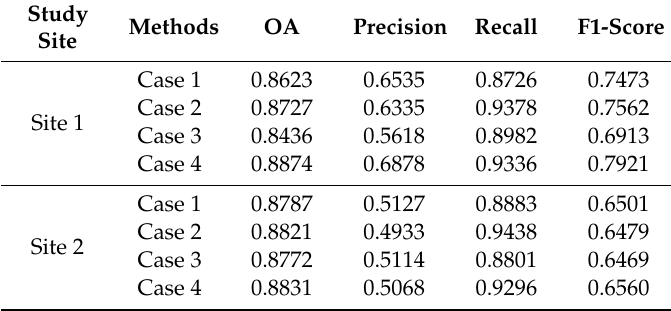
Table 4. Accuracy of CD maps generated via traditional approaches using a CD